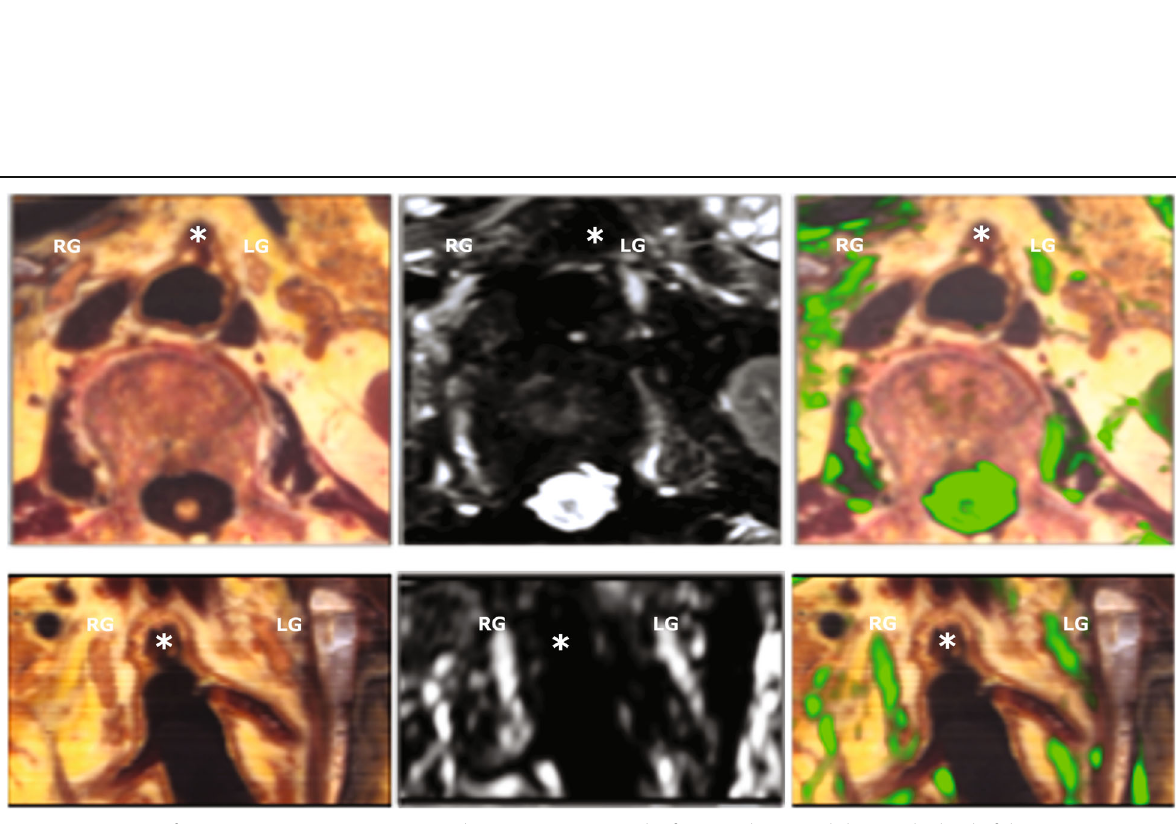
Fig. 4 Comparison of ex vivo cryomacrotome images and 3D SHINKEI images. The first row shows axial slices at the level of the superior mesenteric artery trunk: the cryomacrotome section (left), the corresponding 3D SHINKEI (middle), and an overlay (in green) of the 3D SHINKEI image on the corresponding cryomacrotome image (right). The second row shows the same data set reformatted in the coronal plane. The white asterisk indicates the position of the superior mesenteric artery. The locations of the right and left ganglia of the celiac plexus are indicated by RG and LG, respectively